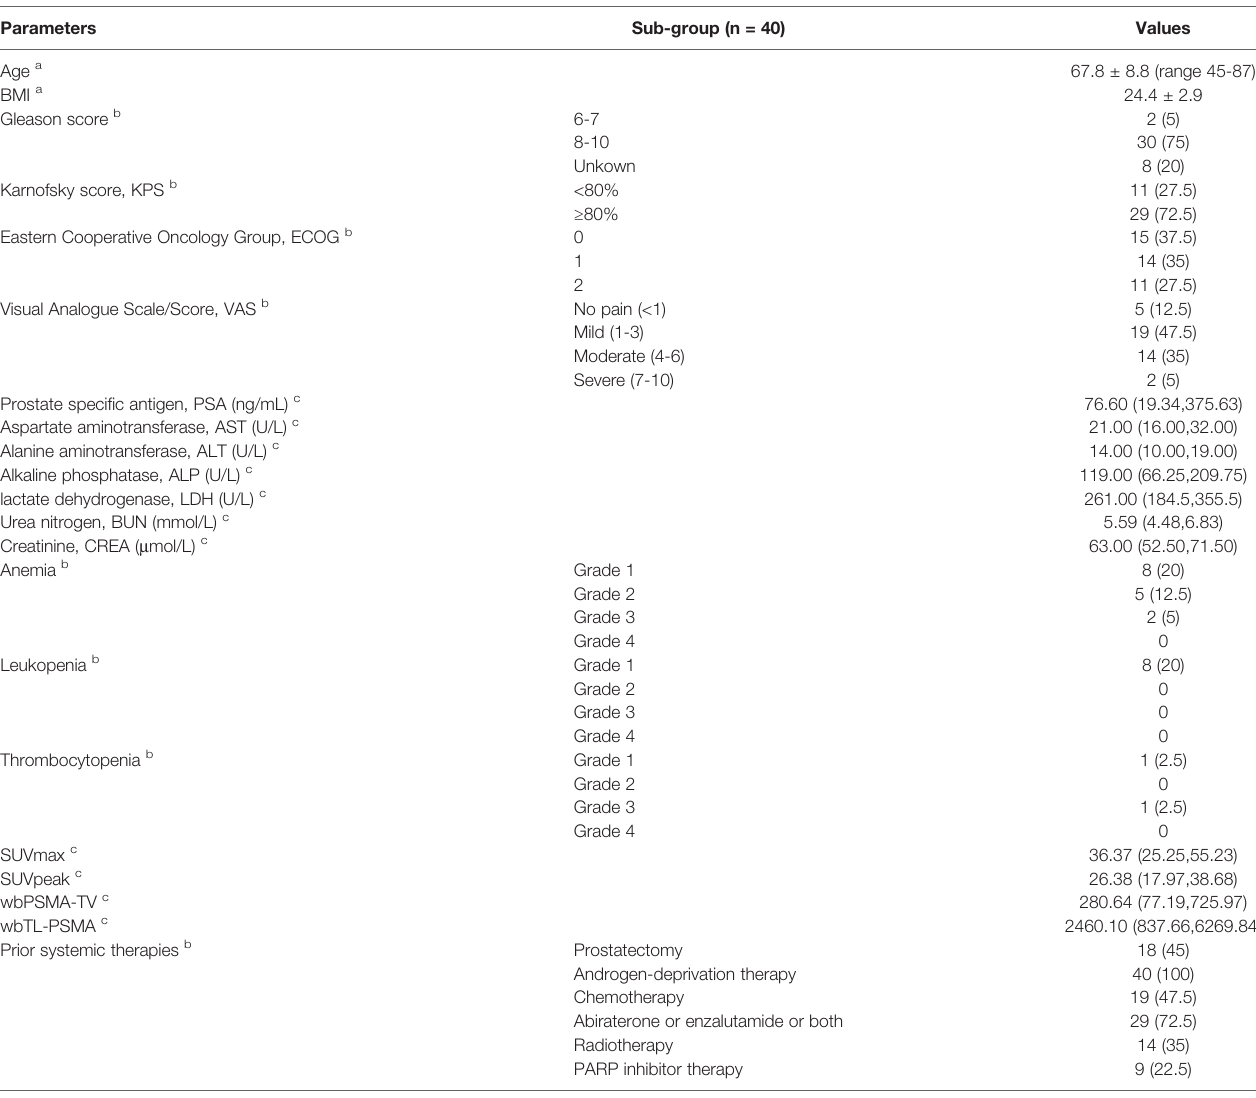
TABLE 1 | Characteristics of patients ’